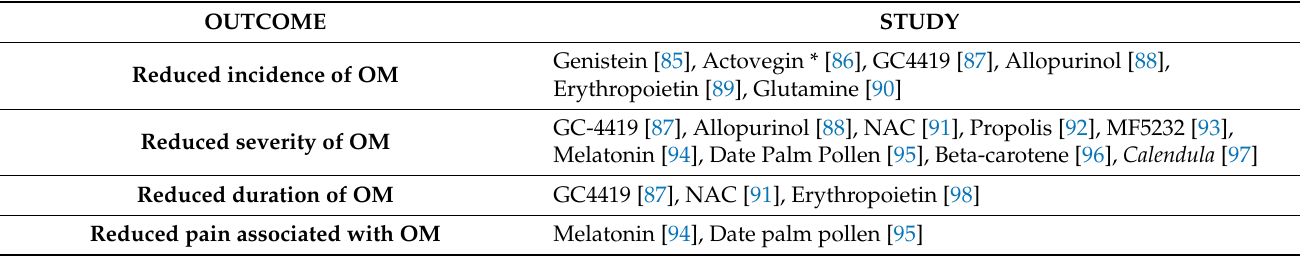
Table 4. Interventions with statistically significant results for various outcomes. OUTCOME